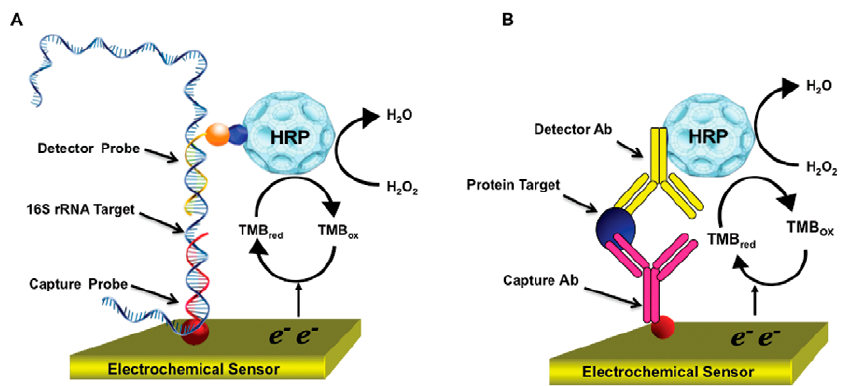
Figure 17. Illustration of urine-based detection of nucleic acids and proteins. ( A ) Schematic of pathogen identification based on sandwich hybridization of bacterial 16S rRNA with capture and detector oligonucleotide probes; ( B ) Schematic of immunoassay based on sandwich detection host urinary protein with capture and detector antibodies [133].